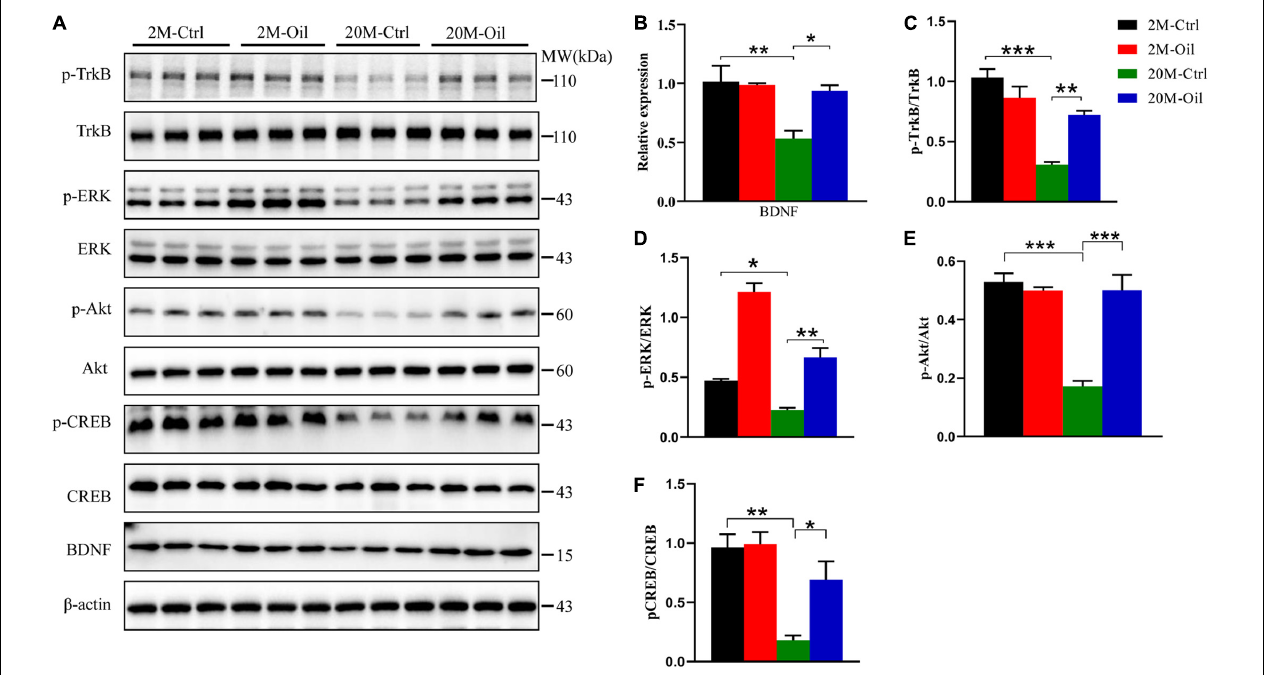
FIGURE 4 | Acer truncatum seed oil administration activated BDNF signal pathway in aging mice. Compared with 2-month-old (2M-Ctrl) mice, the protein levels of BDNF, p-TrkB, p-ERK, p-Akt, and p-CREB decreased in 20-month-old (20M-Ctrl) mice, were reversed by oil treatment, which measured by western blotting (A) , and quantitative analyses (B–F) . One-way ANOVA followed by Tukey’s multiple comparison tests, * p < 0.05, ** p < 0.01, *** p < 0.001. All data were expressed as mean ± SEM, n = 3 mice for each group.